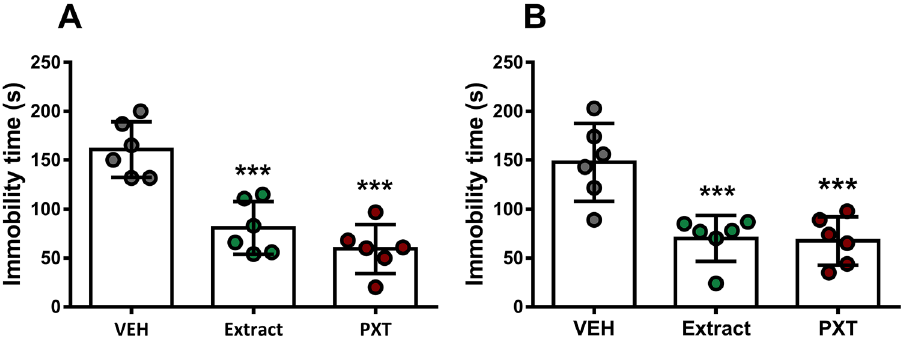
Figure 4. Effect of crude D. viscosa root extract and PXT on immobility time in FST. ( A ) Single or ( B ) sub-chronic (14-day, daily) administration of crude D. viscosa root extract (5 mg/kg i.p.) or PXT (10 mg/kg i.p.) produced reductions in immobility time in FST (One-way ANOVA with Dunnett’s test: A: p < 0.0001; B: p < 0.0001). Data are expressed as mean (± SD). Abbreviations are as follows: VEH, vehicle; Extract, crude D. viscosa root extract; PXT, paroxetine. ***, p < 0.0001.